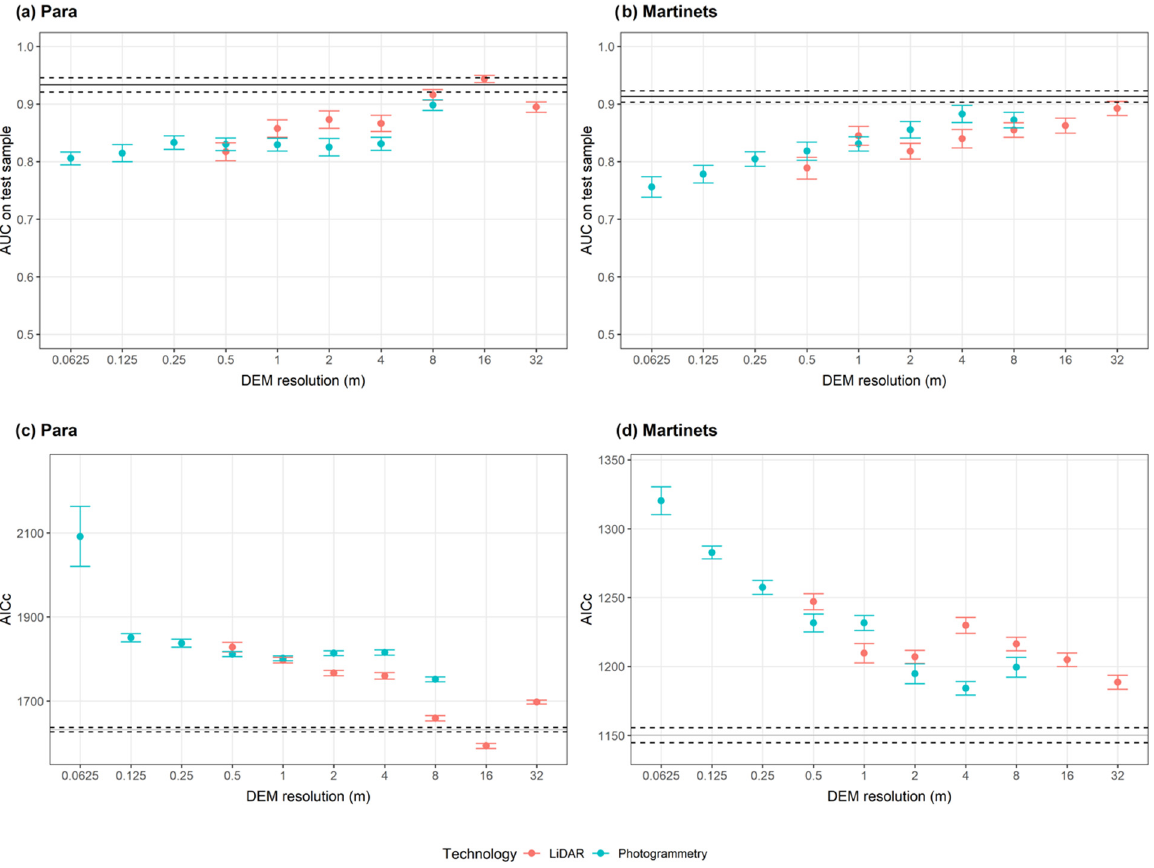
Figure 4. MaxEnt SDM performances evaluated using AUCtest and AICc at Para (( a , c ), respectively) and Martinets (( b , d ), respectively) as a function of variable resolution ( x -axes) and DEM-acquisition technology (LiDAR in orange, PHOTO in blue). Each point represents the evaluation criteria mean ± sd, based on the results of 20 model iterations for the input variables. The horizontal black lines represent the mean ± sd of the “combination” model calculated for each site using the variable resolutions that best differentiated plant occurrence points from random background